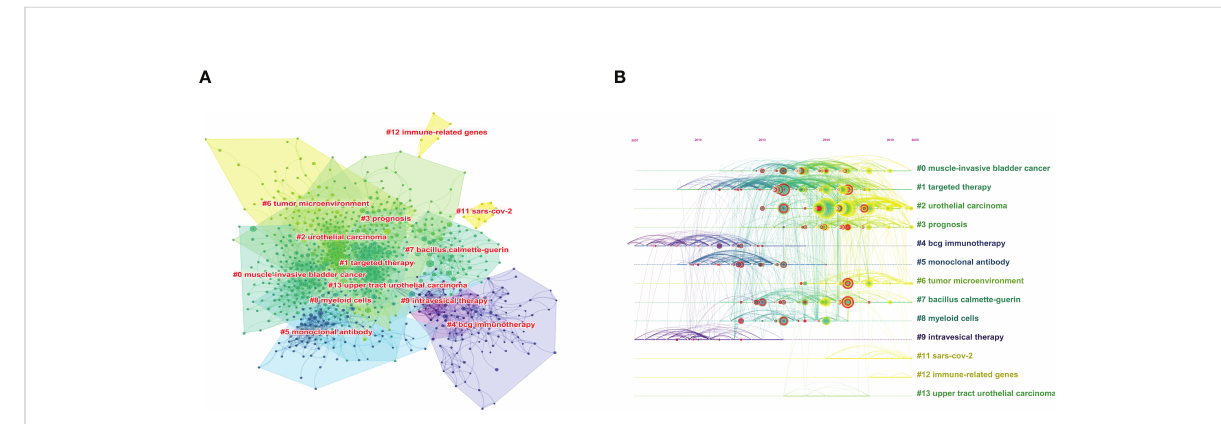
FIGURE 7 The cluster view map (A) and timelines view map (B) of co-cited references analysis generated by CiteSpace software.